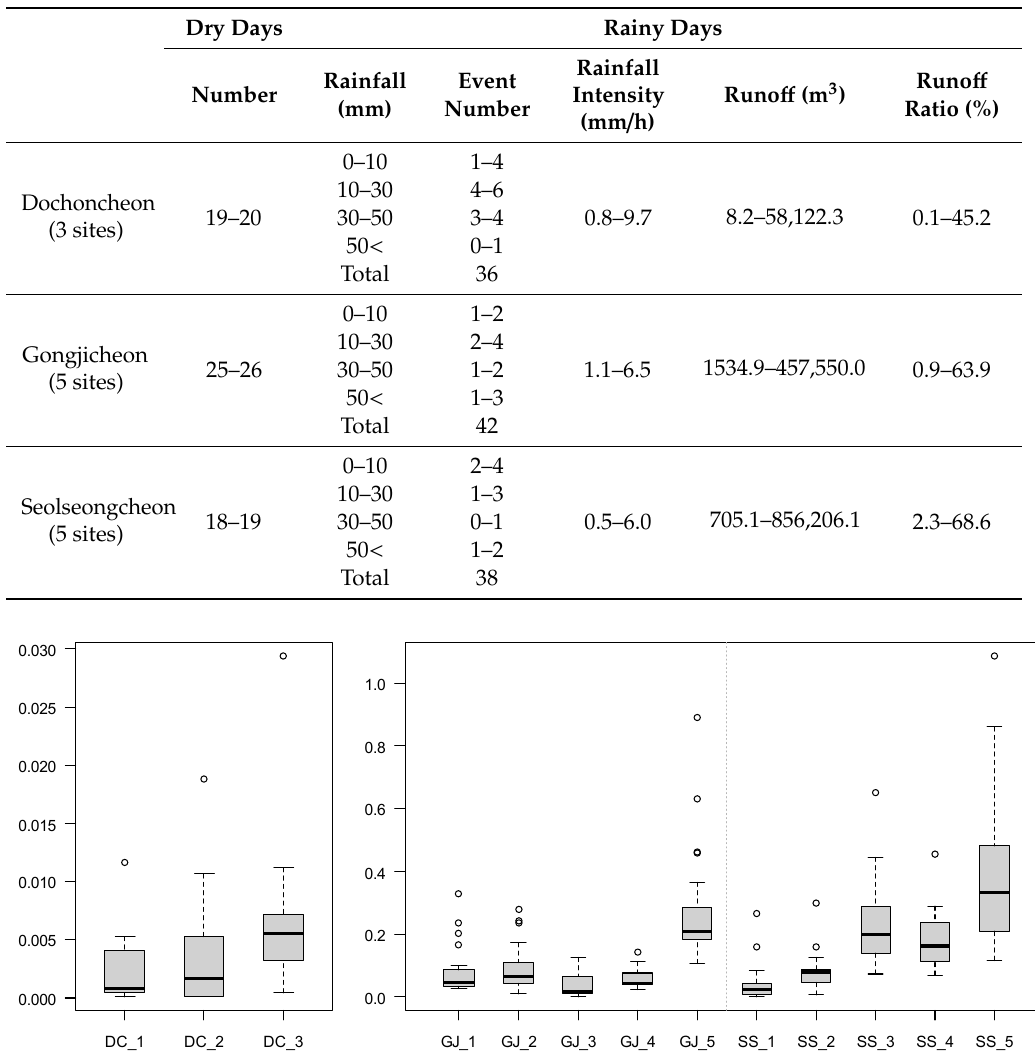
Table 2. Number of surveys during dry and rainy days at each site.